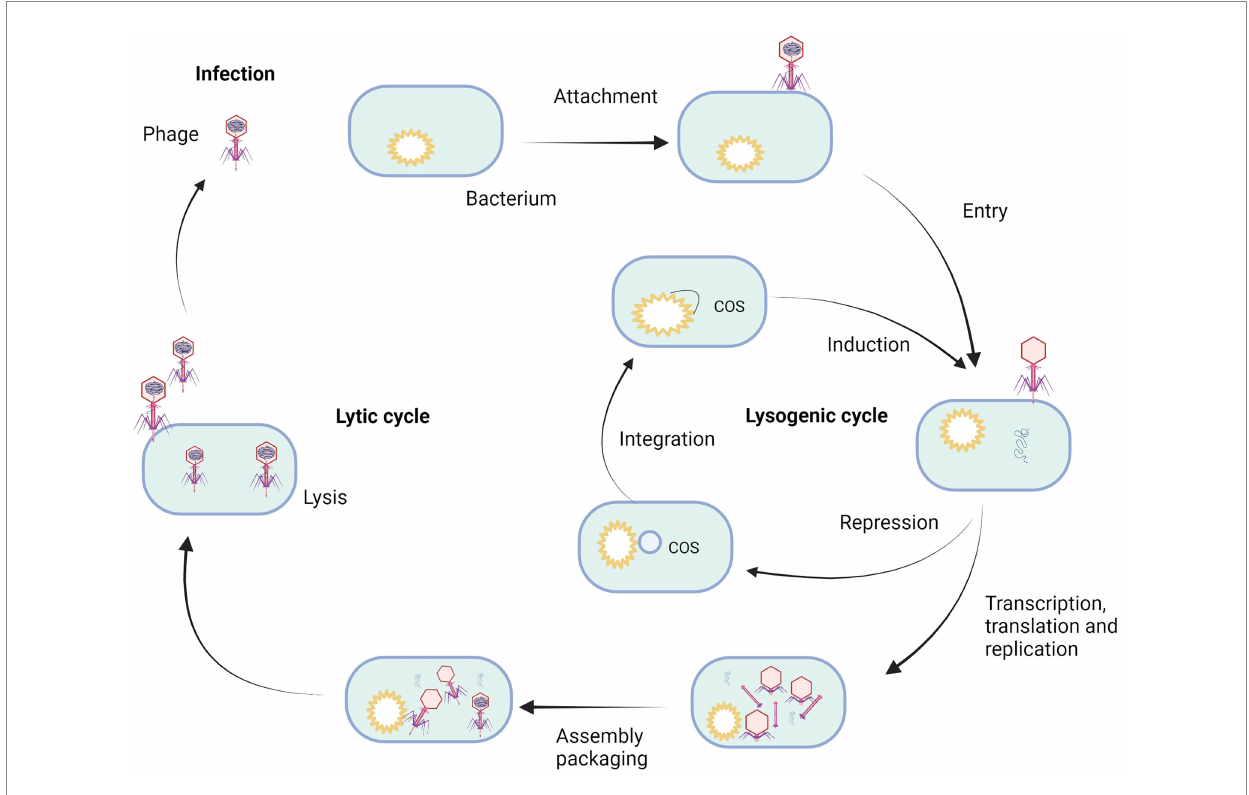
FIGURE 2 Life cycle of bacteriophage. Created with